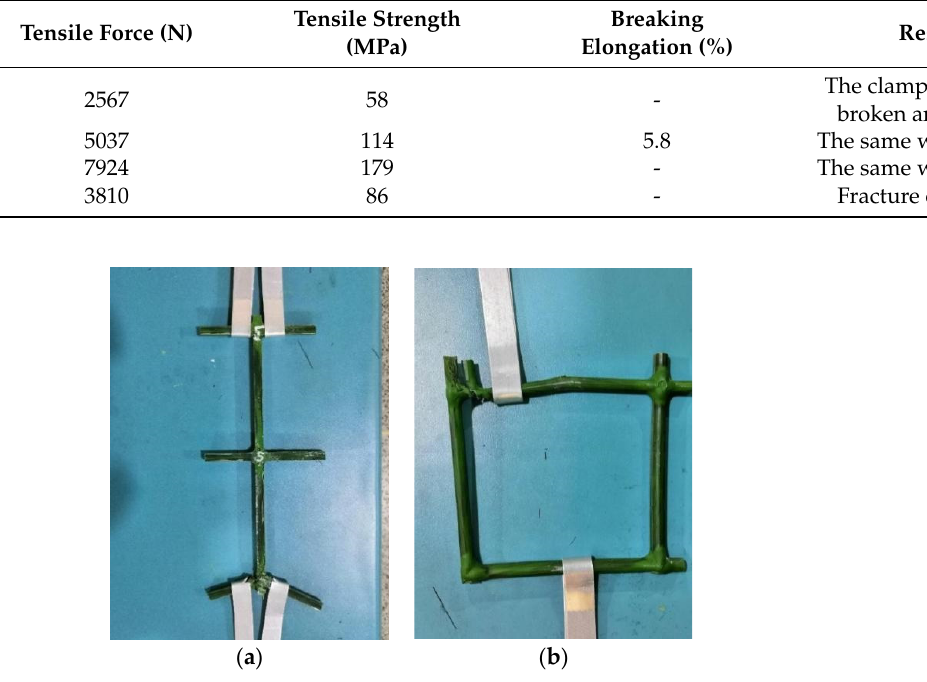
Figure 2. Failure of specimen. ( a ) Single BFR. ( b ) BFR